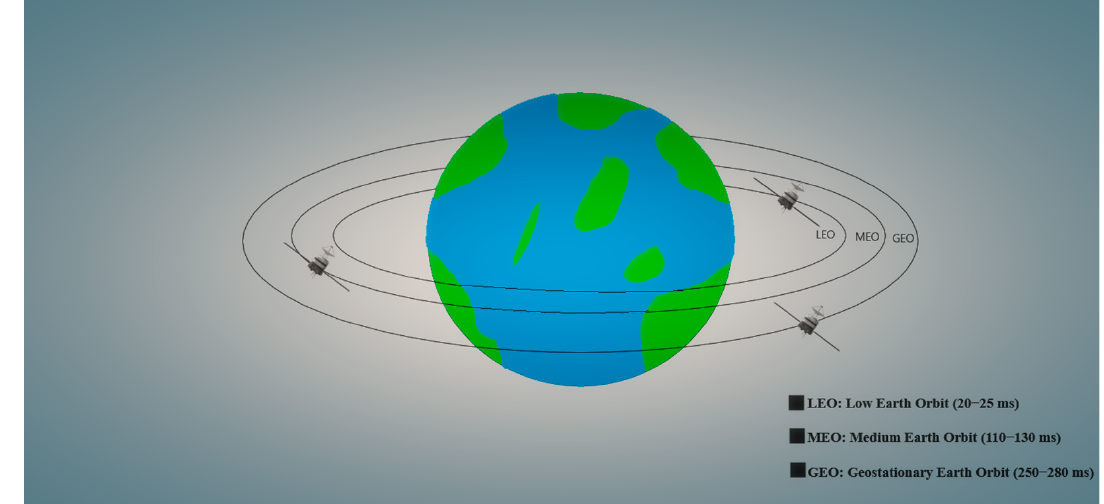
Figure 1. Different types of satellite orbits around the Earth.